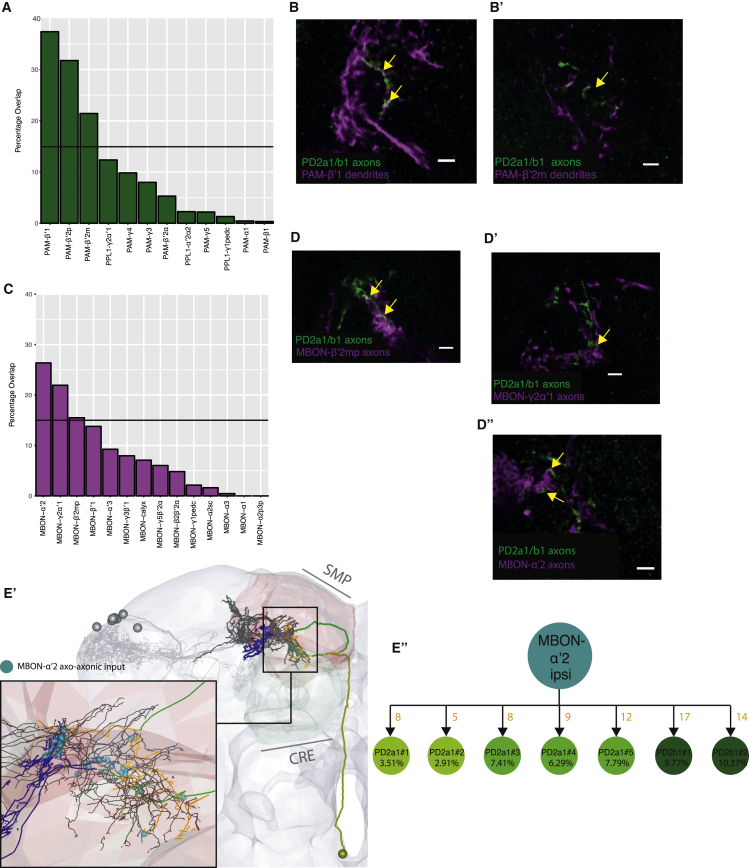
PD2a1 and PD2b1 Axons Interdigitate and Interact with DAN Dendrites and MBON Axons(A) Histogram of light microscopy overlap between a mask of PD2a1 and PD2b1 axons and masks of the dendrites of DANs (along the x axis).(B and B’) Confocal imaging of double labeling between PD2a1 and PD2b1 axons (labeled with GFP, green) and DAN dendrites (labeled with RFP, magenta). PAM-β’1 dendrites (B) and PAM-β’2m dendrites (B’).(C) Histogram of light microscopy overlap between a mask of PD2a1 and PD2b1 axons and masks of the dendrites of most MBONs (along the x axis).(D–D”) Confocal imaging of double labeling between PD2a1 and PD2b1 axons (labeled with GFP, green) and MBONs (labeled with RFP, magenta). Shown are MBON-β’2mp axons (D), MBON-y2ɑ’1 axons (D’), and MBON -ɑ′2 axons (D”).(E) Visualization of MBON-ɑ’2 axons interdigitating with PD2a1 and PD2b1 axons (black) in the EM volume. Other PD2a1 and PD2b1 neurons are shown in gray. Inset: positions of axo-axonic connections from MBON-ɑ’2 onto PD2a1 and PD2b1 neurons, shown as cyan spheres.(E’) Summary of ipsilateral MBON-ɑ’2′s axo-axonic connectivity onto PD2a1 and PD2b1 cells. Double labeling images are examples from n = 3 brains. For double labeling, the scale bar represents 5 μm.